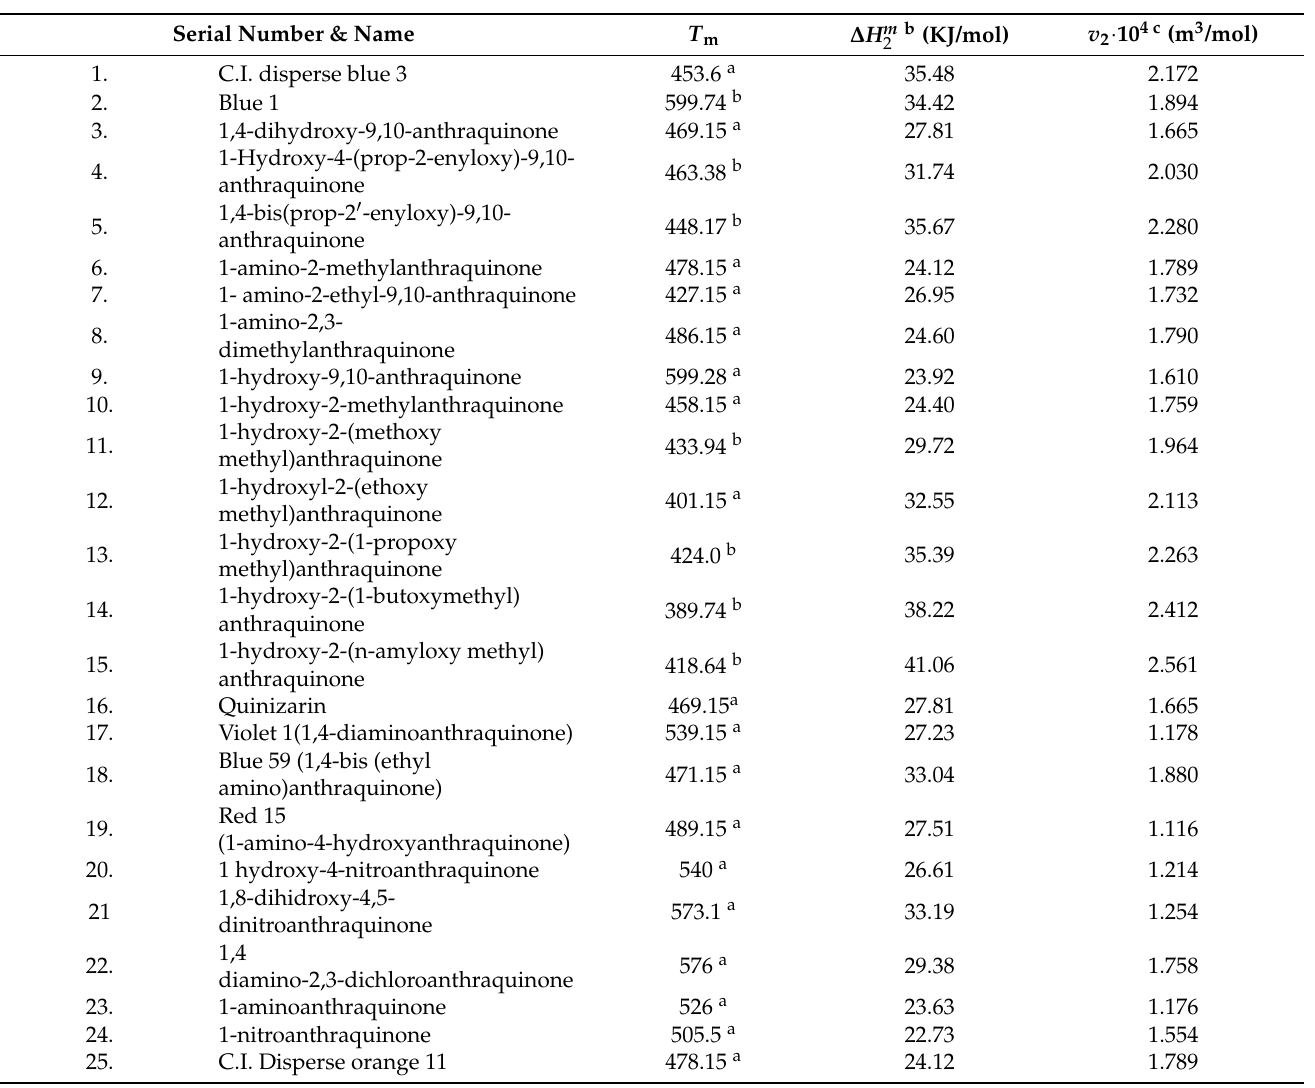
Table 1. Physical properties of the